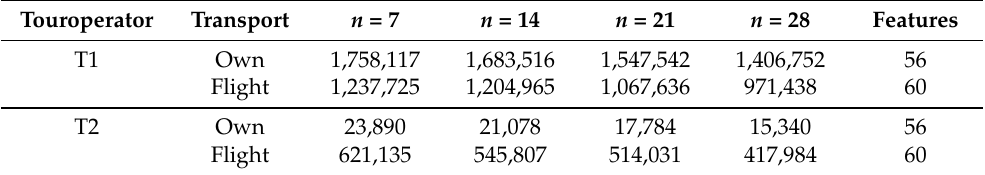
Table 2. Sizes of data sets for various n and transport types, for k =